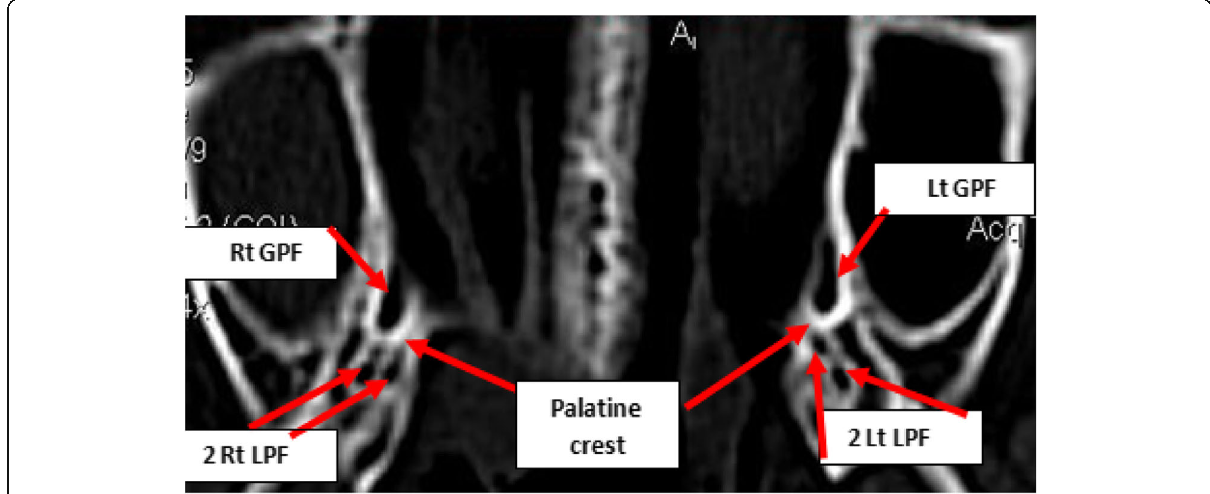
Fig. 1 A CT scan at the region of hard palate illustrating the greater and lesser palatine foramina as well as the presence of palatine crest